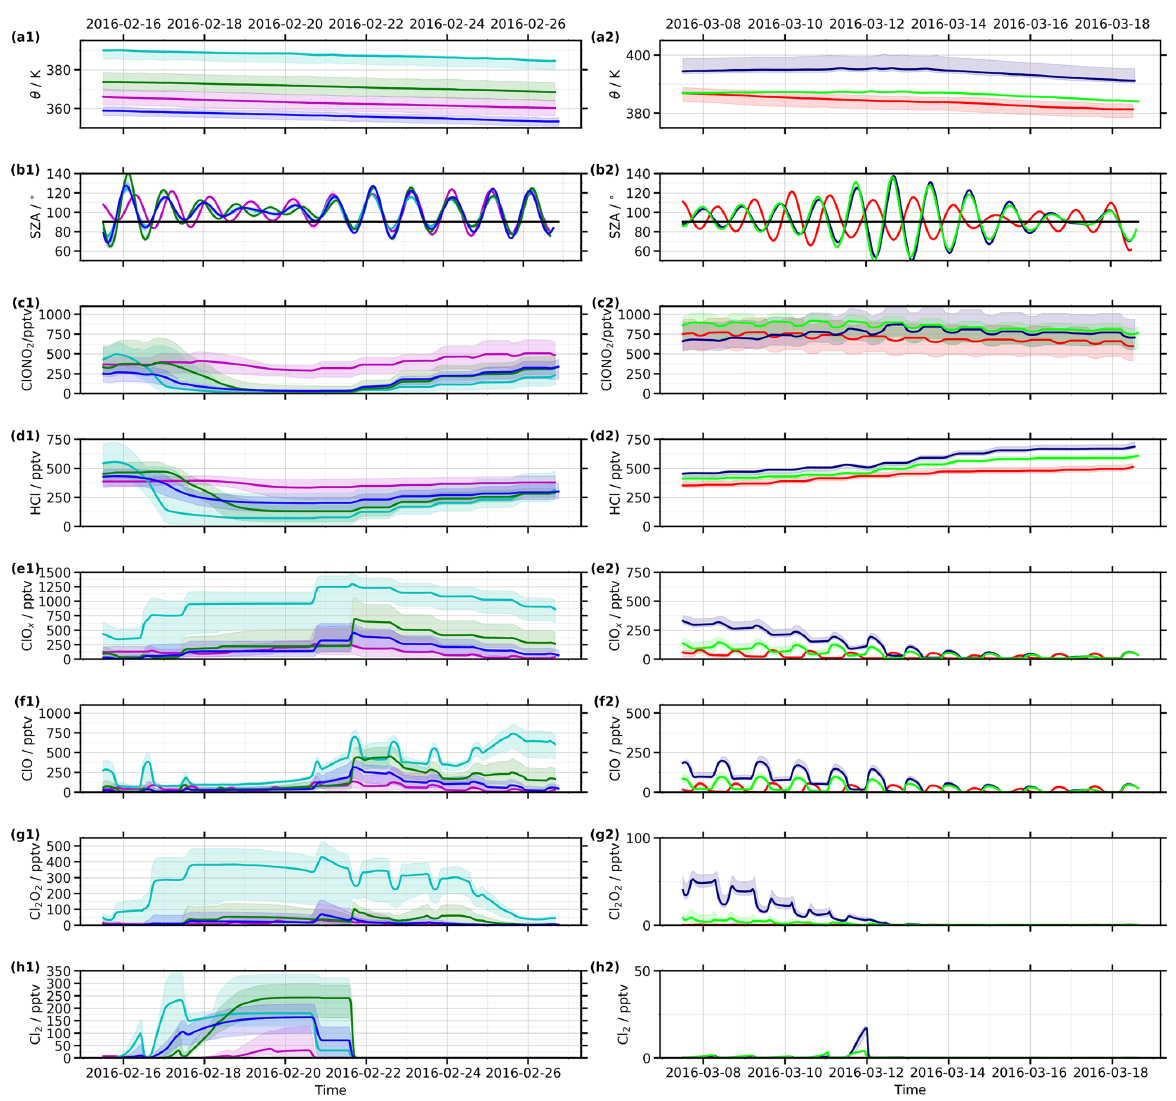
Figure 12. Modeled temporal evolution of (a) potential temperature, (b) solar zenith angle (SZA, the 90 ◦ threshold is marked with a black line), (c) ClONO 2 , (d) HCl, (e) ClO x , (f) ClO, (g) Cl 2 O 2 , and (h) Cl 2 for (1) flight PGS14 (left column) and (2) flight PGS21 (right column). These trajectories are color-coded as defined in Fig. 11(a)–(c) and (e)–(g). Solid lines show the mean of all trajectories connected with these regions and the light colors show minimum and maximum values among those trajectories. Please note the different ordinate scales in each